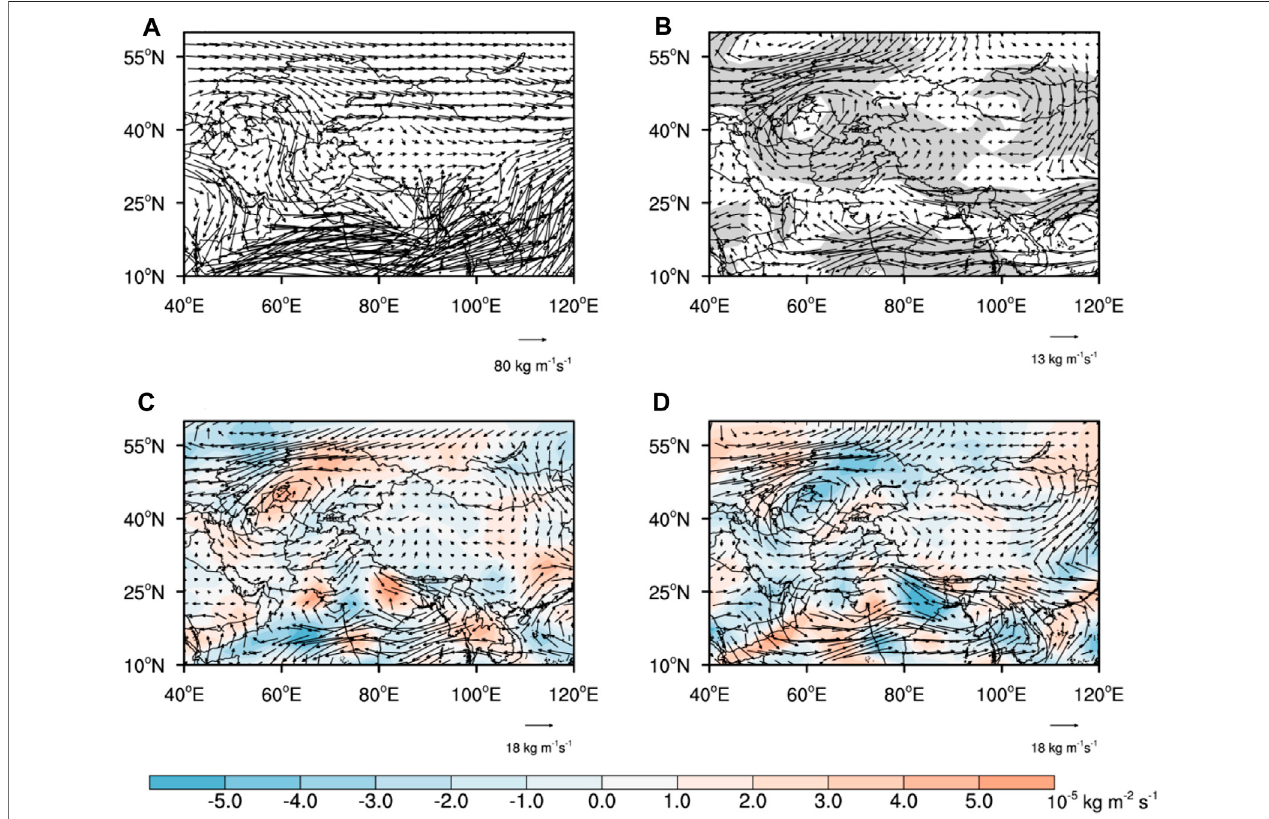
FIGURE 6 | (A) The spatial distribution of the summer vertically integrated (surface to 500 hPa) water vapor fl ux averaged from 1971 to 2016, (B) regression of summer vertically integrated (surface to 500 hPa) water vapor fl ux against the CARI during 1971 – 2016, shaded regions show signi fi cance at α (cid:2) 0 . 05 level, (C) composite distribution of water vapor fl ux anomalies (vector) and corresponding to divergence (shadow) in strong CARI years, (D) as (C) but in weak CARI years.